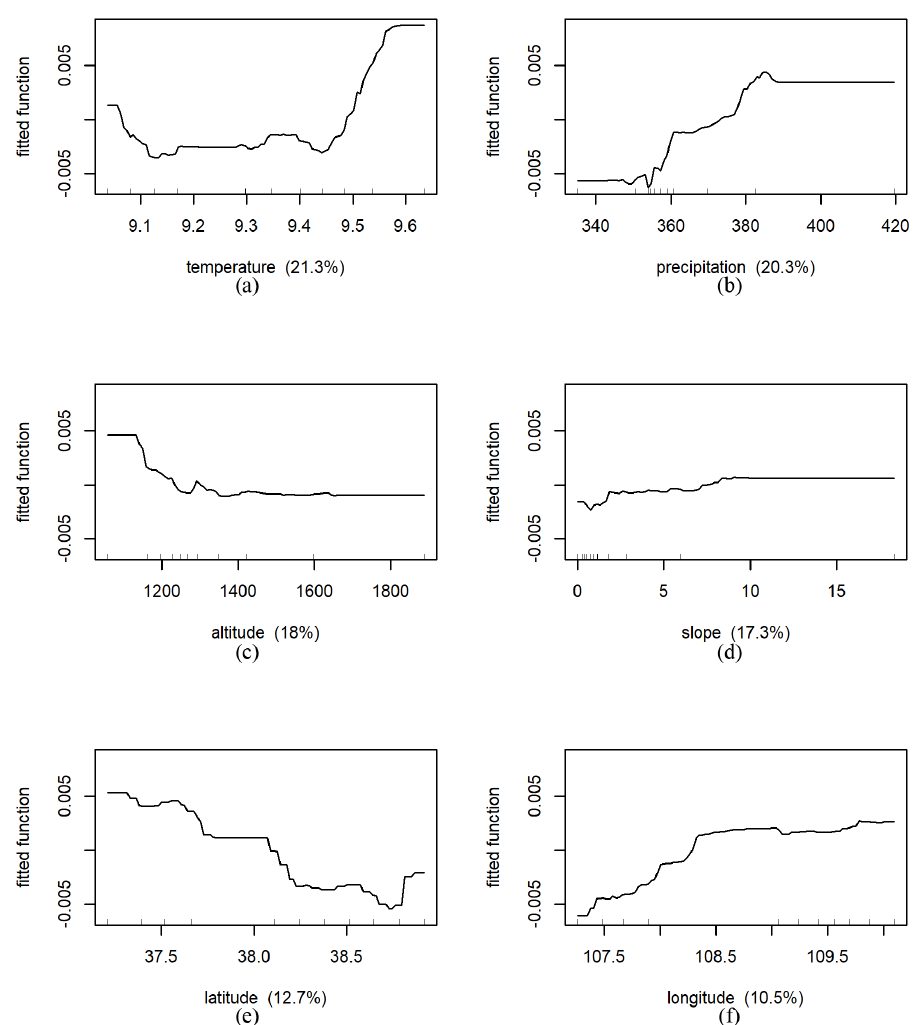
Figure 21. Results of marginal effects of environmental factors on NDVI under barren land in whole Shaanxi Province (The fitted function of NDVI vs. ( a ): temperature (°C), ( b ): precipitation (mm), ( c ): altitude (m), ( d ): slope (°), ( e ): latitude (N), ( f ): longitude (E), respectively. The x -axis denotes the predictive variable; the contents in brackets in the title of the x -axis represent relative influence. The y -axis denotes the marginal effect of the selected variables by “integrating” out the other variables).